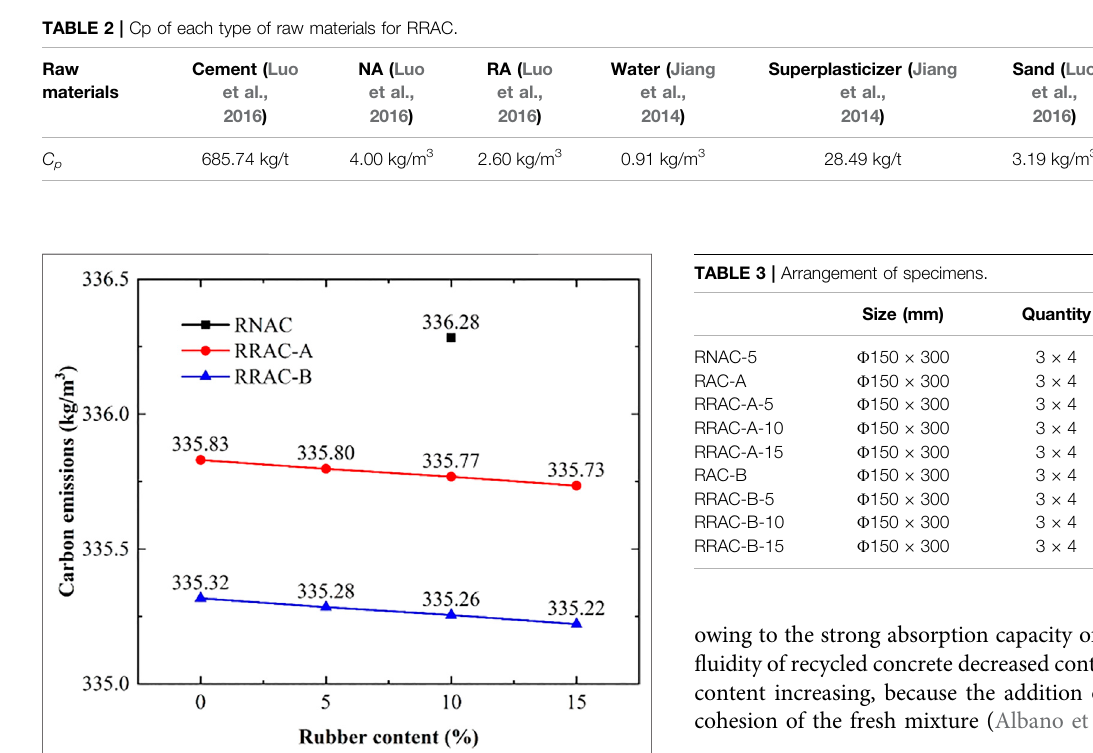
FIGURE 1 | Carbon emissions of RNAC and